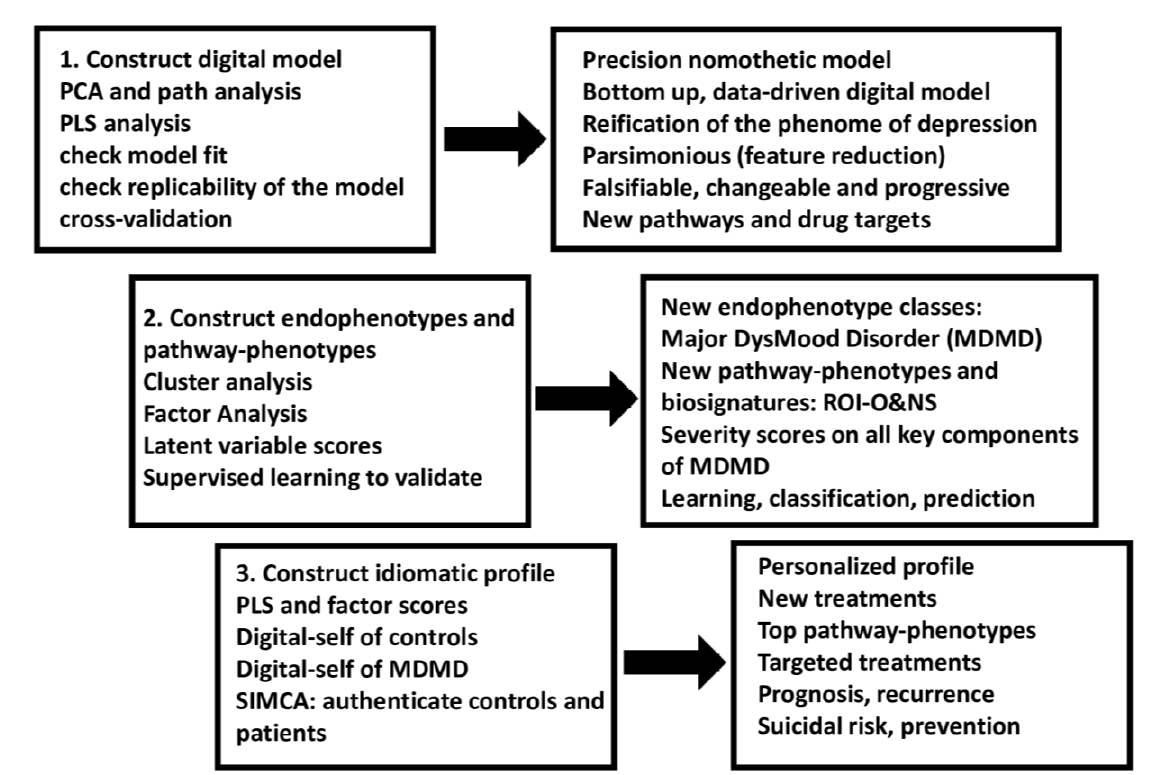
Figure 7. Three steps of precision medicine applied to precision nomothetic models of mood disor- ders and the different products generated during this process. These methods allow us to construct a digital giant model of depression comprising all building blocks of the disease, endophenotype classes (including MDMD or major dysmood disorder) and pathway phenotypes (e.g., ROI-AOP, which is a common core underpinning reoccurrence of illness and a specific adverse outcome pathway) and personalized scores on these new constructs and other indicators in the model which together delineate a idiomatic profile for each individual. ROI-O&NS: a pathway phenotype comprising staging of mood disorders and oxidative and nitrosative stress biomarkers.